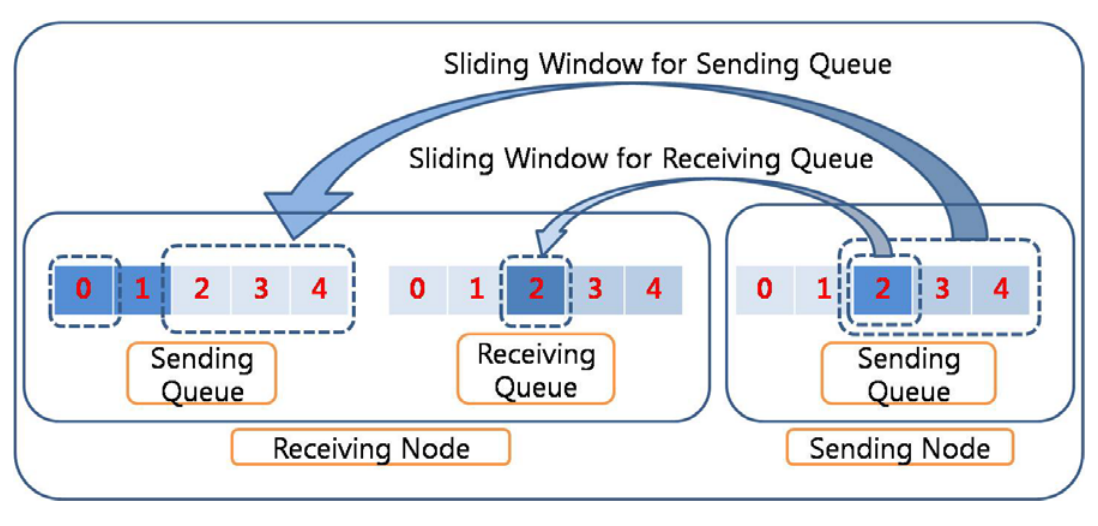
Figure 4. Sliding window for sending queue. Sliding window for sending queue prevents the packet drops due to the overflow of sending